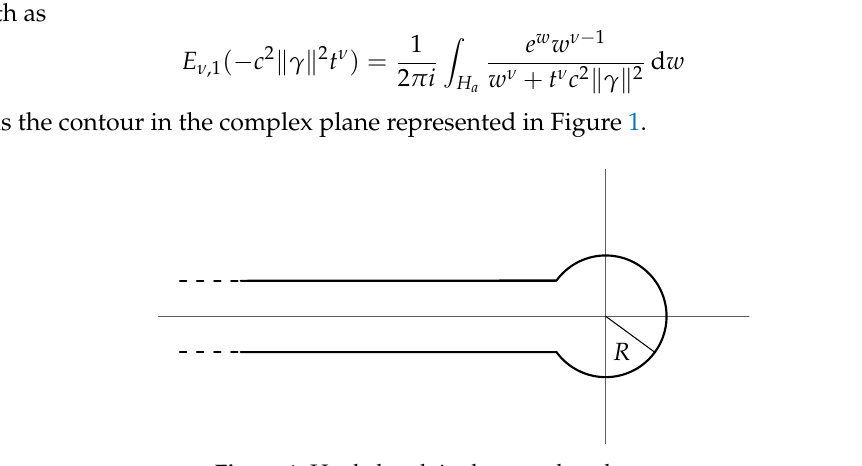
Figure 1. Hankel path in the complex plane.